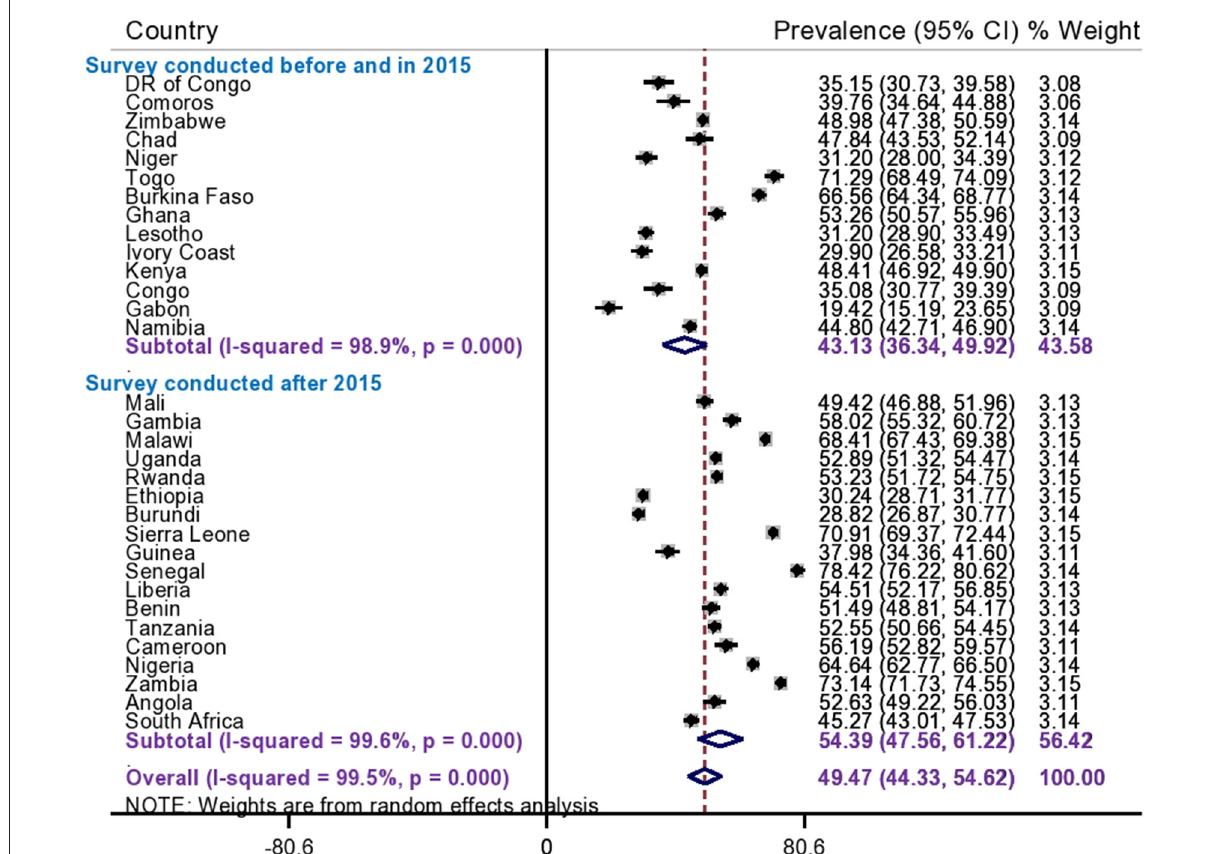
FIGURE3 Subgroup analysis of informed choice of contraceptive methods by survey year in Sub Saharan